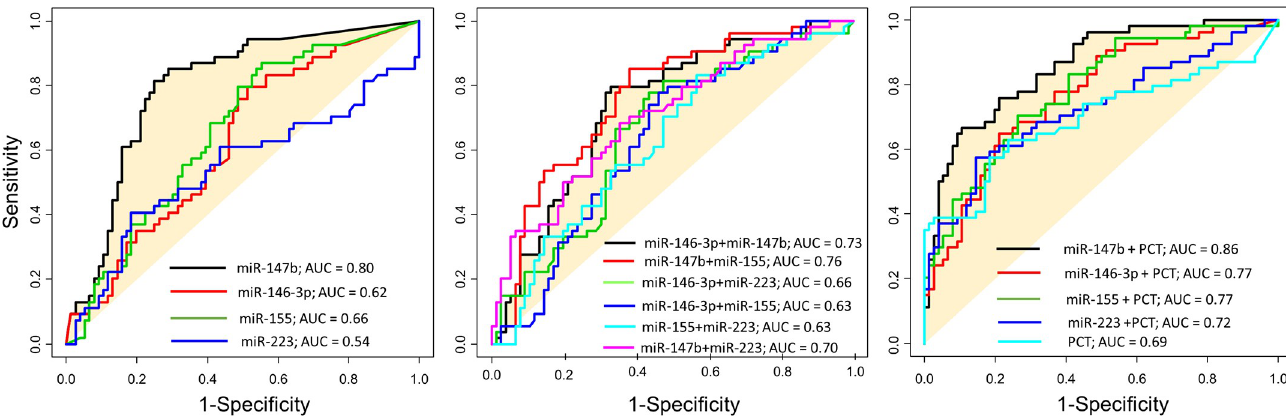
Fig 4. Combination of miR-147b and serological PCT can predict septic shock. Diagnostic performance of the models built based on random forest models with single or double combination of miRNAs or double combination of individual miRNA and PCT in differentiating septic shock patients from non-septic shock